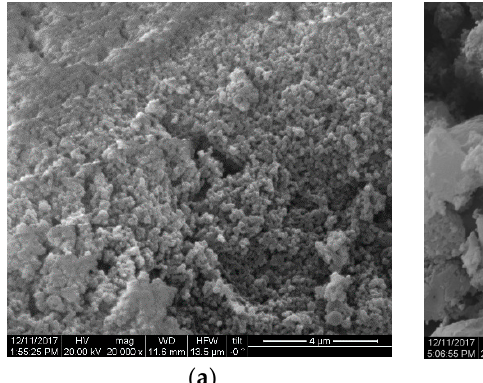
Figure 4. Morphology of lignin isolated with HOS-SE pretreatment with 60% v/v ethanol content ( a ) and after homogenization at 500 bar in ethanol/water solution with ethanol content of ( b ) 0% v/v ; ( c ) 50% v/v ; and ( d ) 75% v/v .